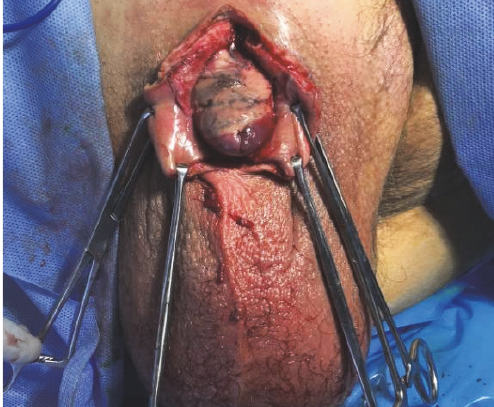
Figure 2: Dorsal and ventral slits with exposure of the glans revealing nonviable tissue on the dorsal aspect of the penis.